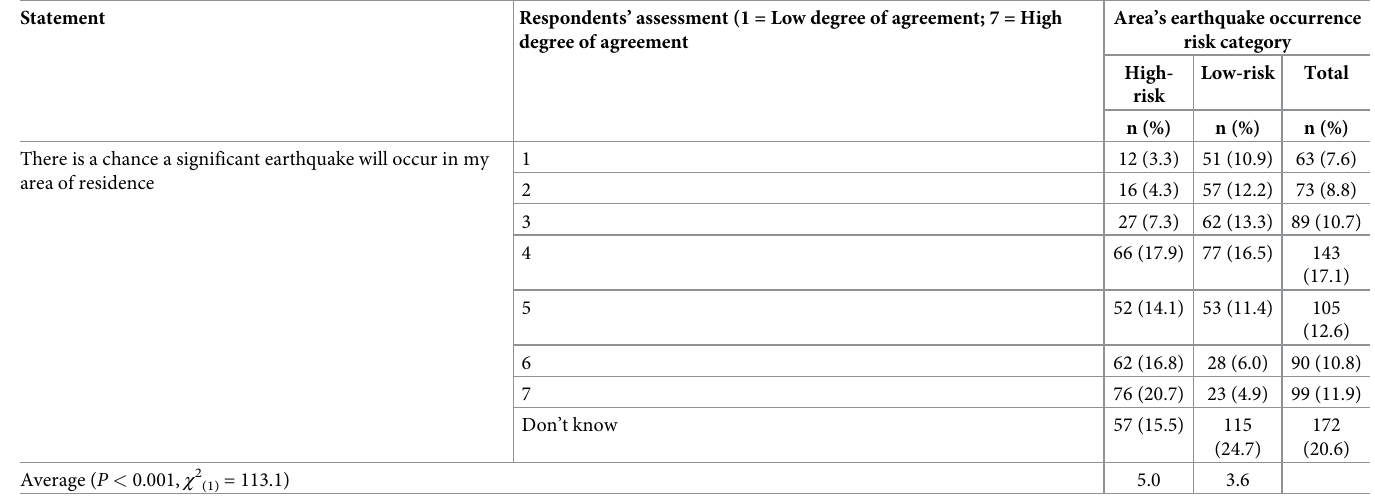
Table 3. Respondents’ assessments of chances an earthquake will occur in their area of residence (n = 834).